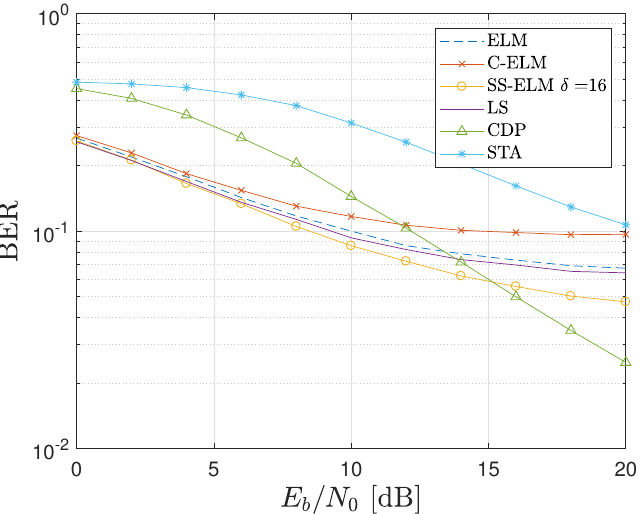
Figure 14. BER as a function of E b / N 0 for different evaluated techniques and system configuration 1.